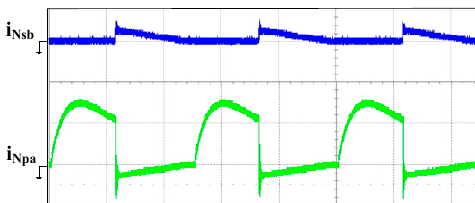
Figure 15. Experiment of current waveforms (i Nsb, i Npa ), i Nsb, i Npa : 500 mA/div, Time: 20 µs/div.